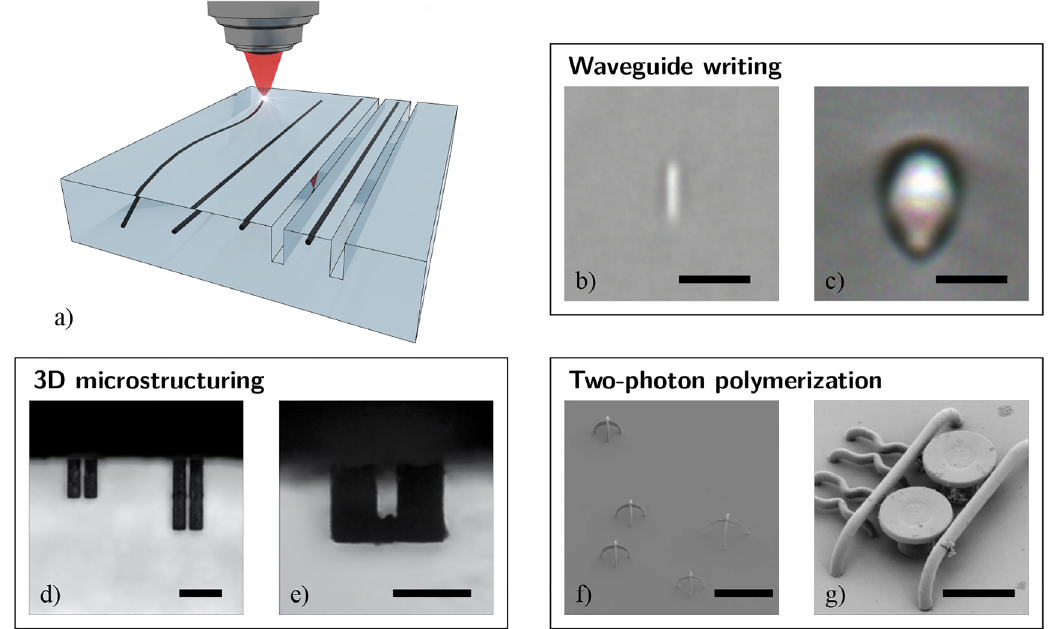
Figure 2: Graphical summary of the capabilities of FLM. Irradiation of a transparent substrate with a focused femtosecond laser beam, to produce buried modified tracks, is represented pictorially in (a); boxes report examples of the different available fabrication processes (b)–(g). For direct waveguide writing, microscope pictures of the cross-section of FLM waveguides in two different materials are reported: (b) Single-mode waveguide operating in the visible, realized in fused silica substrate by a single femtosecond laser scan at 50 kHz pulse repetition rate (authors’ own work, scalebar is 10 μ m); (c) single-mode waveguide operating at 1550 nm, inscribed in Eagle2000 (Corning Inc.) alumino-borosilicate glass by multiple overlapped laser scans at 5 MHz, followed by thermal annealing (adapted from Ref. [ 31 ], scalebar is 10 μ m). For 3D microstructuring, cross-sections of different excavated structures, produced by water-assisted laser ablation in EagleXG (Corning Inc.) alumino-borosilicate glass, are reported (both adapted from Ref. [ 32 ]): (d) microtrenches realized on both sides of an optical waveguide (scalebar is 200 μ m); (e) U-shaped hollow microstructure, surrounding a thin glass beam where an optical waveguide has also been inscribed (scalebar is 100 μ m). For two-photon polymerization, pictures taken with an electronic microscope of fabricated microstructures are shown: (f) Crossed-arc polymeric waveguides, each crossing contains one pre-characterized single-photon emitter (adapted from Ref. [ 33 ], scalebar is 20 μ m); (g) 3D structure containing several key photonic elements, such as waveguides, couplers, and microdisc resonators (adapted from Ref. [ 34 ], scalebar is 10 μ